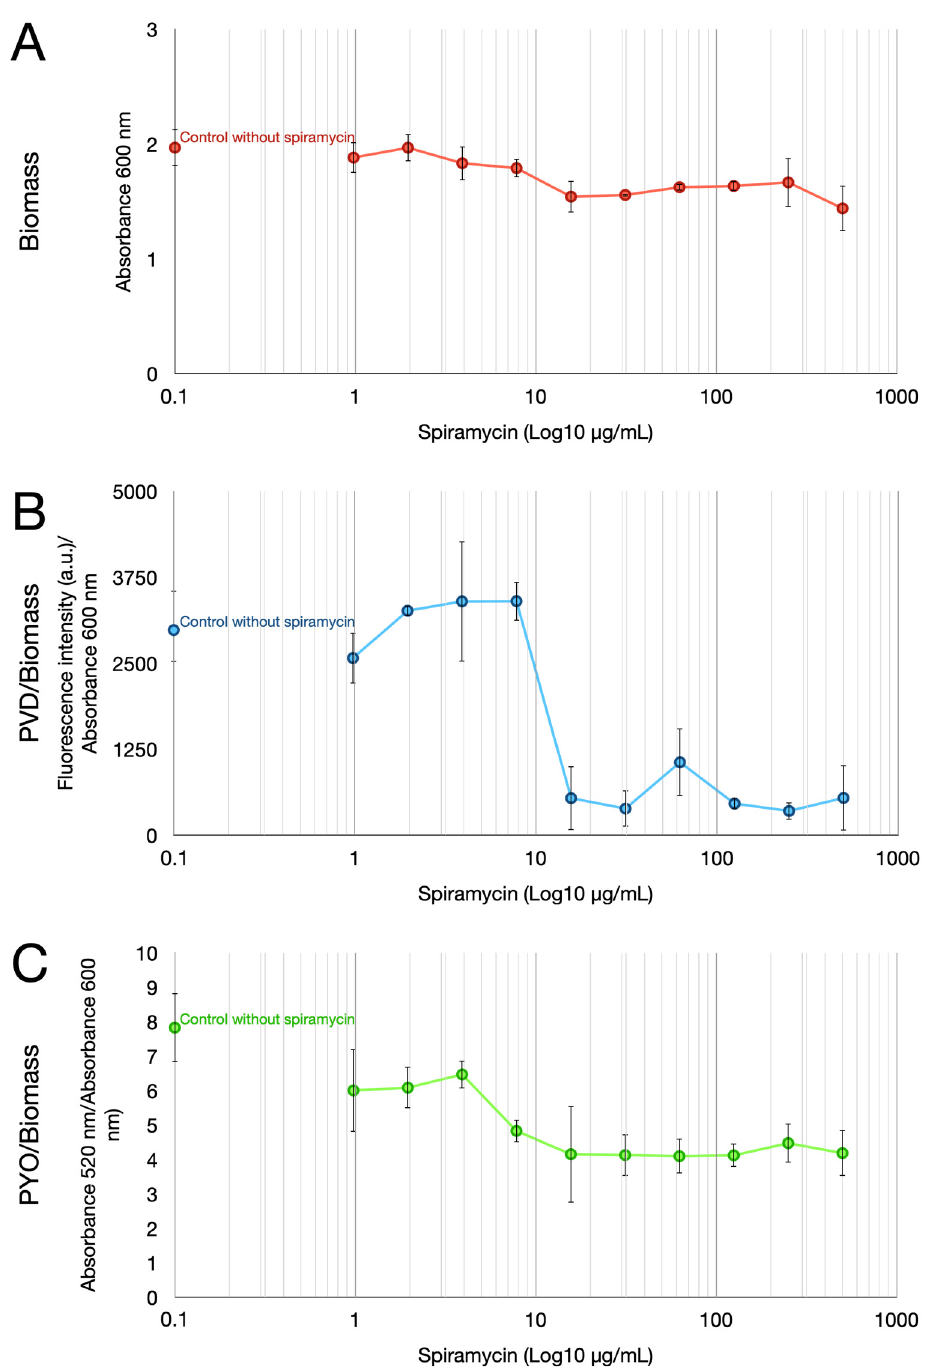
Figure 1. Biomass, PVD, and PYO production by P. aeruginosa GG-7R growing in LB for 24 h at 37 °C and 180 rpm. ( A ) Biomass was determined by absorbance at 600 nm measurement. ( B ) PVD in exhausted LB was assayed by fluorescence emission (excitation at 405 nm, emission at 450 nm). The value was normalized by the biomass (absorbance at 600 nm). ( C ) PYO in exhausted LB was assayed by optical absorbance at 520 nm. The value was normalized by the biomass (absorbance at 600